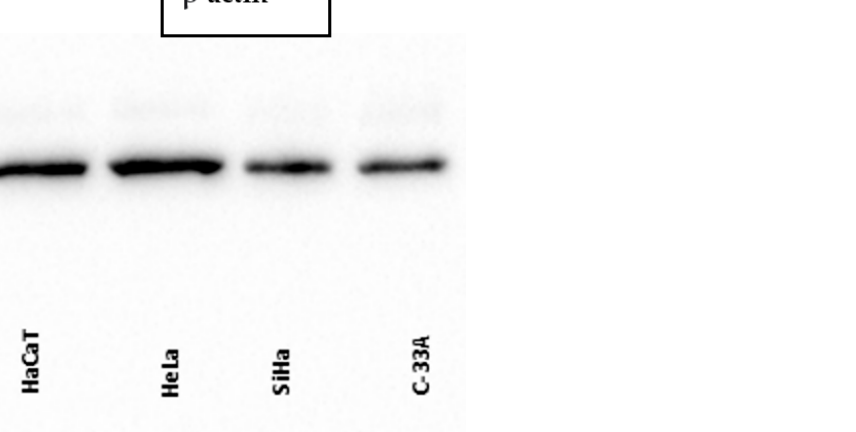
Figure 4. WB: β -actin expression in HaCat, HeLa, SiHa and C-33 A cell lines. The molecular weight